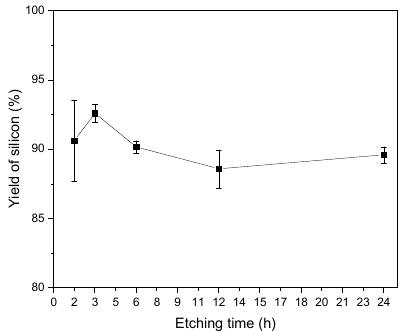
Figure 3. Yields of the silicon as a function of etching time. Approximately 90% of the solid that underwent chemical treatment was recovered regardless of the treatment time. The divergence observed in the error bars was believed to be caused by the glass fragments present in some samples. Different particles from samples treated at 1.5, 6, and 24 h were analyzed by Energy Dispersive X-ray Spectroscopy. We observed that the X-ray photon peaks corresponding to Cu, and Pb were not shown in the spectra indicating that its concentration was below the detection limit of the EDS technique. The composition analysis after different immer- sion times showed the presence of elements such as Ag and Sn in samples recovered after 1.5 h of treatments (Figure 4a). The typical spectra of the samples immersed for a longer time in the etching solution show the reduction of impurity in silicon samples (Figure 4b,c). A deeper analysis would have to be done to determine the composition of the samples at every stage during the etching processes. 0.0 0.5 1.0 1.5 2.0 2.5 3.0 3.5 4.0 4.5 5.002 46810121416 I n t en s i t y ( a . u . )